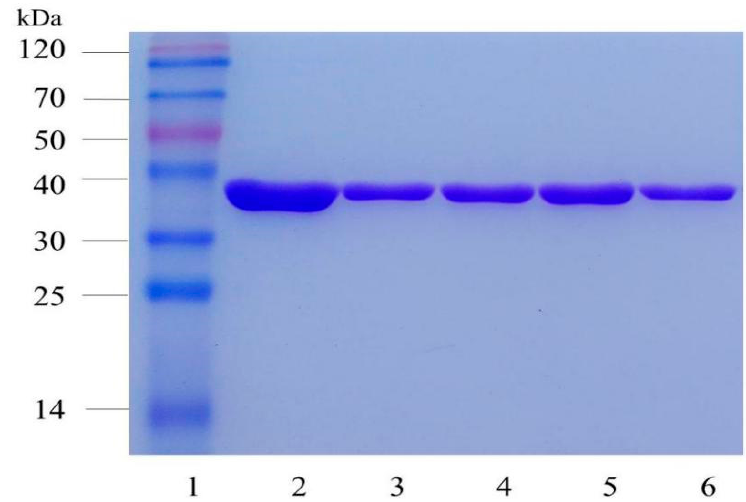
Figure 2. The SDS-PAGE analysis of wild-type and AT-ATA mutants. Lanes: 1, Protein marker; 2, Wild-type; 3, L118T; 4, L118A; 5, L118I; and 6, L118V.